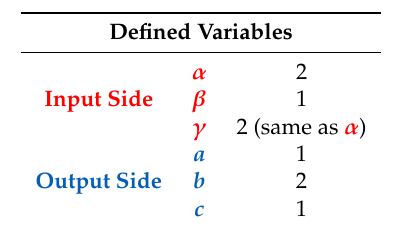
Table 2. Values for the six parameters for a two-module Input-Parallel Output-Series (IPOS) power